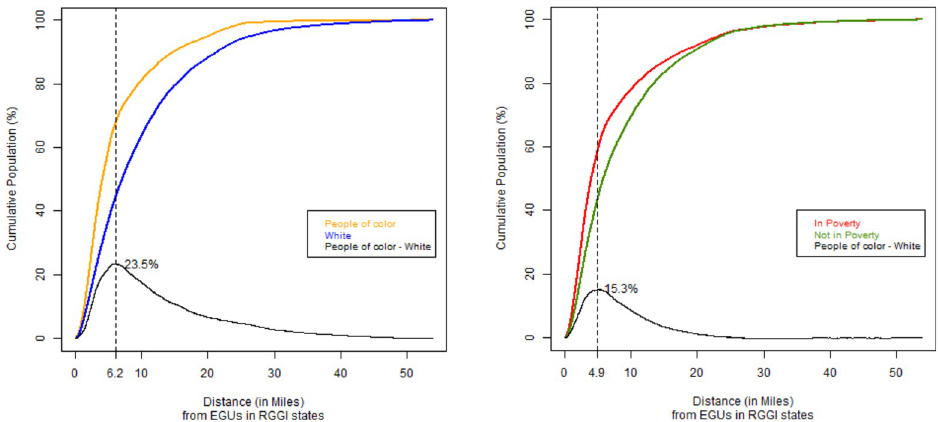
Fig 2. a. Cumulative distribution of people of color and White populations by distance to EGUs in RGGI. Black line indicates between the cumulative population curves. The maximum percent difference is labeled on the figure. Dotted vertical line indicates distance of maximum difference value. b. Cumulative distribution of people living in poverty and people not living in poverty by distance to EGUs in RGGI. Black line indicates difference between the cumulative population curves. The maximum percent difference is labeled on the figure. Dotted vertical line indicates distance of maximum difference value.